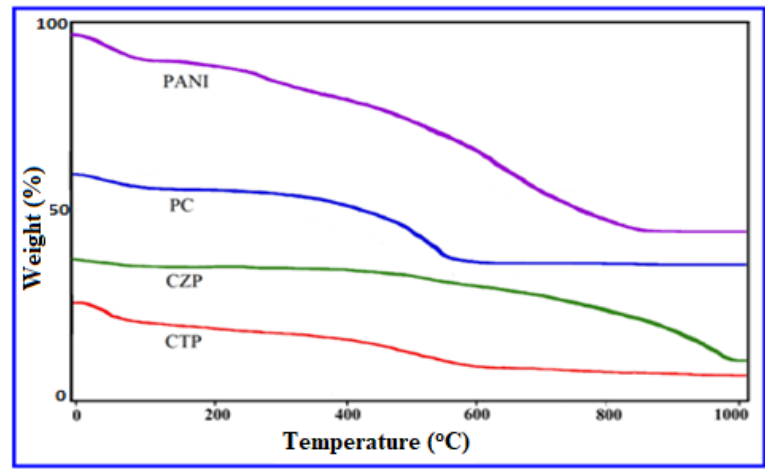
Figure 7. TGA curves of PANI, and its composite nanomaterials (PC, CZP, and CTP).